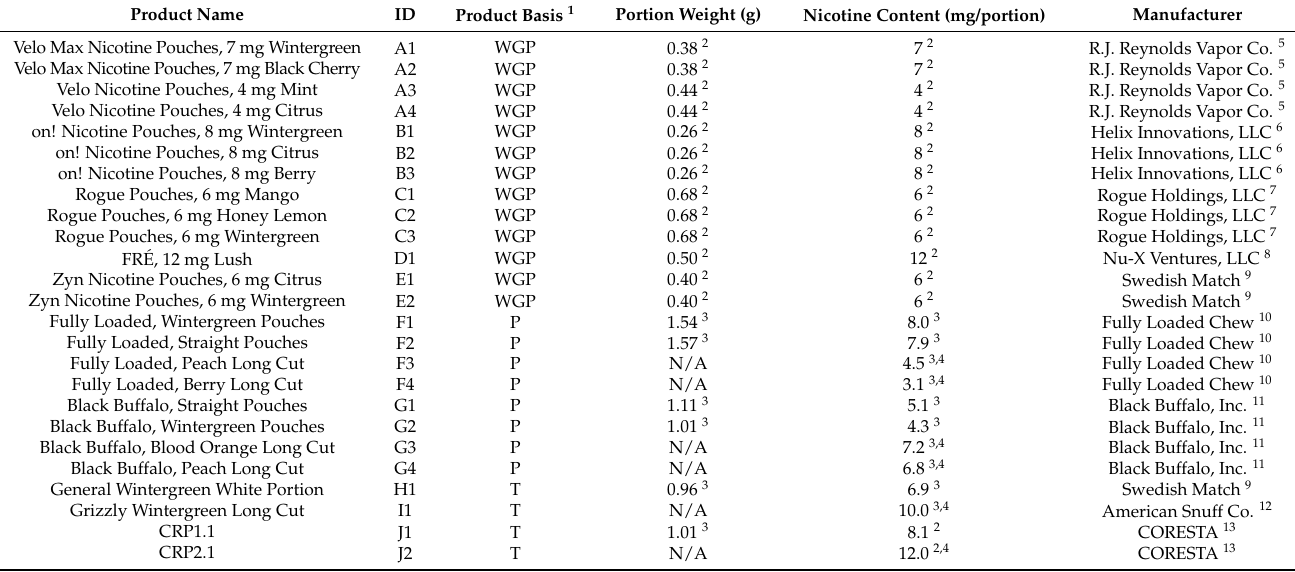
Table 5. Modern oral nicotine products and smokeless tobacco comparators tested in this study.